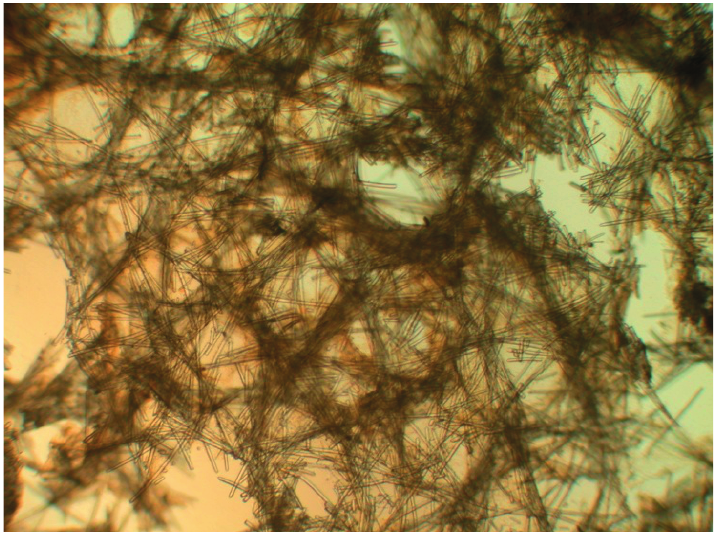
Figure 4. Petrosia sp. specimen: Detail of the ectosome, showing foreign materials.